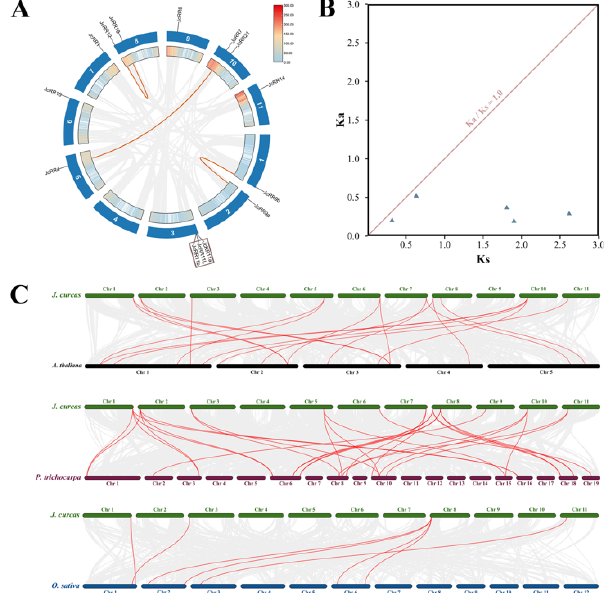
Figure 6. Evolutionary analysis of RRs. ( A ) Gene density and duplications of putative RRs on J. curcas chromosomes. The heatmap represents the density of genes at corresponding positions on the chromosome. Collinear blocks in the whole J. curcas , and red lines indicate duplicated JcRR gene pairs. The dark red rectangle represents tandem duplications. ( B ) Ka/Ks values of duplicated JcRR gene pairs. Five pairs of duplicated JcRR genes with Ka/Ks less than one. The detailed Ka/Ks information of duplication pairs is described in Table S3. ( C ) Collinearity analysis of J. curcas with three other species ( A. thaliana , P. trichocarpa and O. sativa ). Chr, the serial number of each chromosome. The gray lines in the background indicate the collinear blocks between J. curcas and other plant genomes, while the red lines highlight the syntenic RR gene